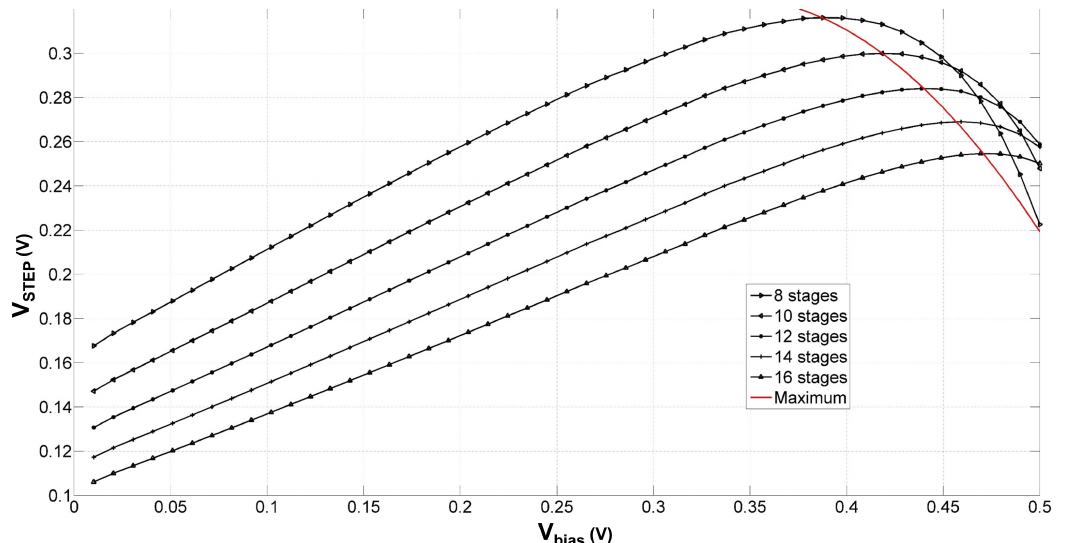
Figure 8. Simulated average step voltage versus the static bias voltage for multiple voltage multipliers differing in the number of stages. ( V AC = 500 mV, C = 3 pF, L = 90 nm, W = 15 µm, f = 1 GHz, R OUT = 1 M Ω